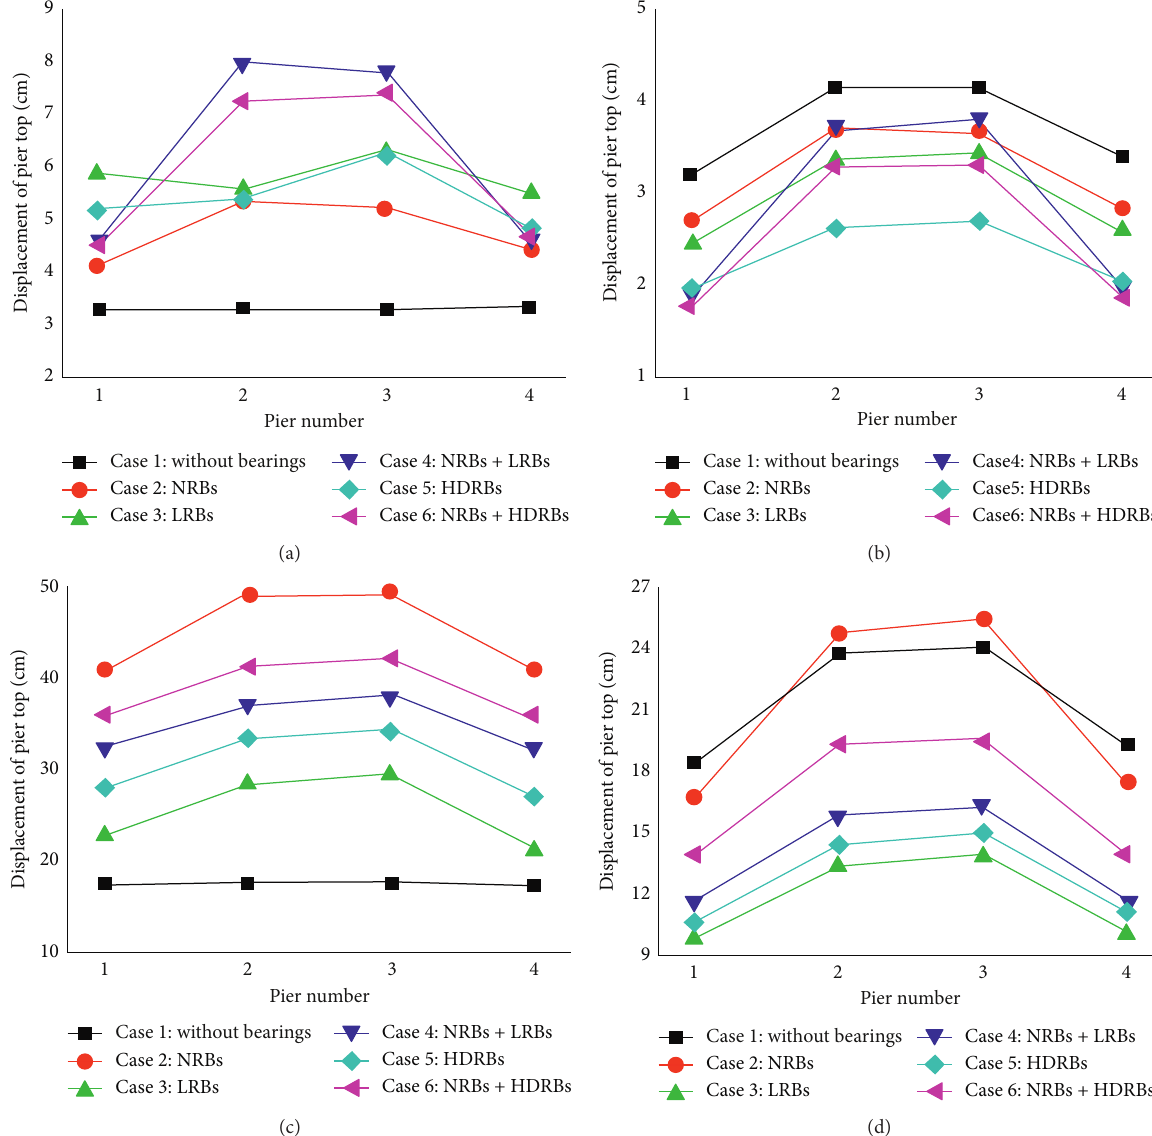
Figure 12: Displacement of the pier top in different cases: (a) longitudinal shear force under the action of small earthquake; (b) lateral shear force under the action of small earthquake; (c) longitudinal shear force under the action of large earthquake; (d) lateral shear force under the action of large